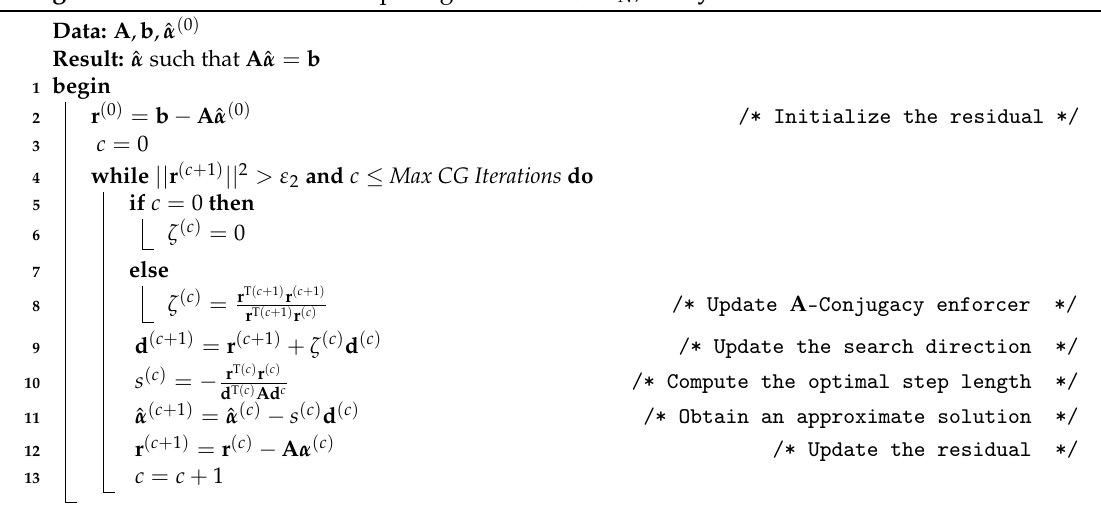
Algorithm 1: Linear CG for computing ˆ α . A = K + λ I N , b =